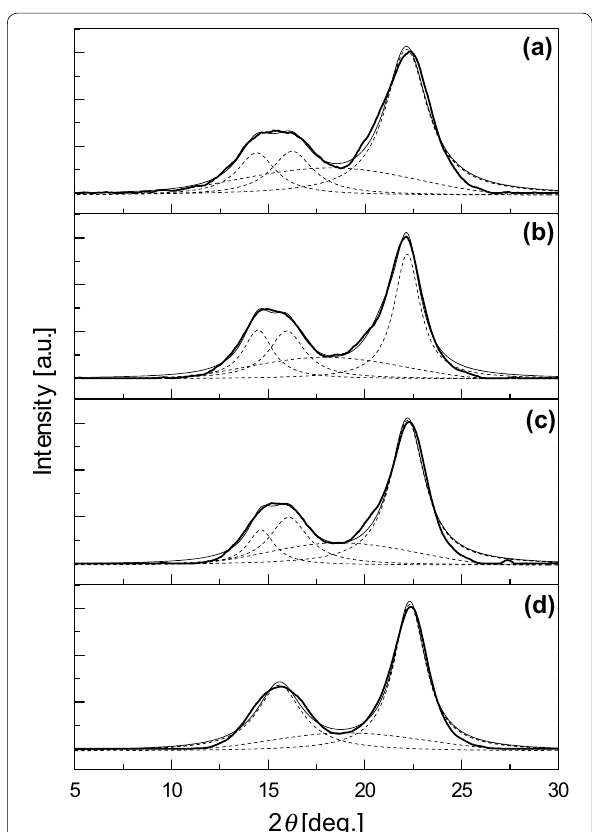
Fig. 5 X-ray diffraction patterns of a untreated Japanese cedar, and Japanese cedar treated with b glycerol at 250 °C for 3 h, c 20% sodium oleate in glycerol at 250 °C for 0.5 h, and d 20% sodium oleate in glycerol at 250 °C for 3 h. Bold solid line shows the X-ray diffraction pattern. Broken and solid lines show the peak separation and sum of the peaks,